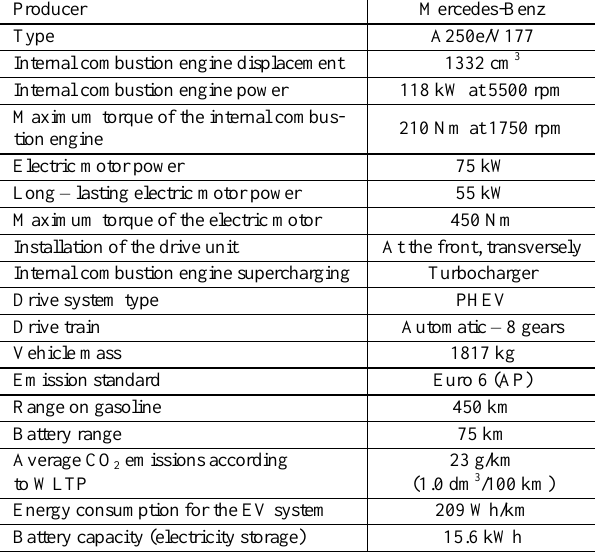
Table 3. Parameters of the tested vehicle [27,